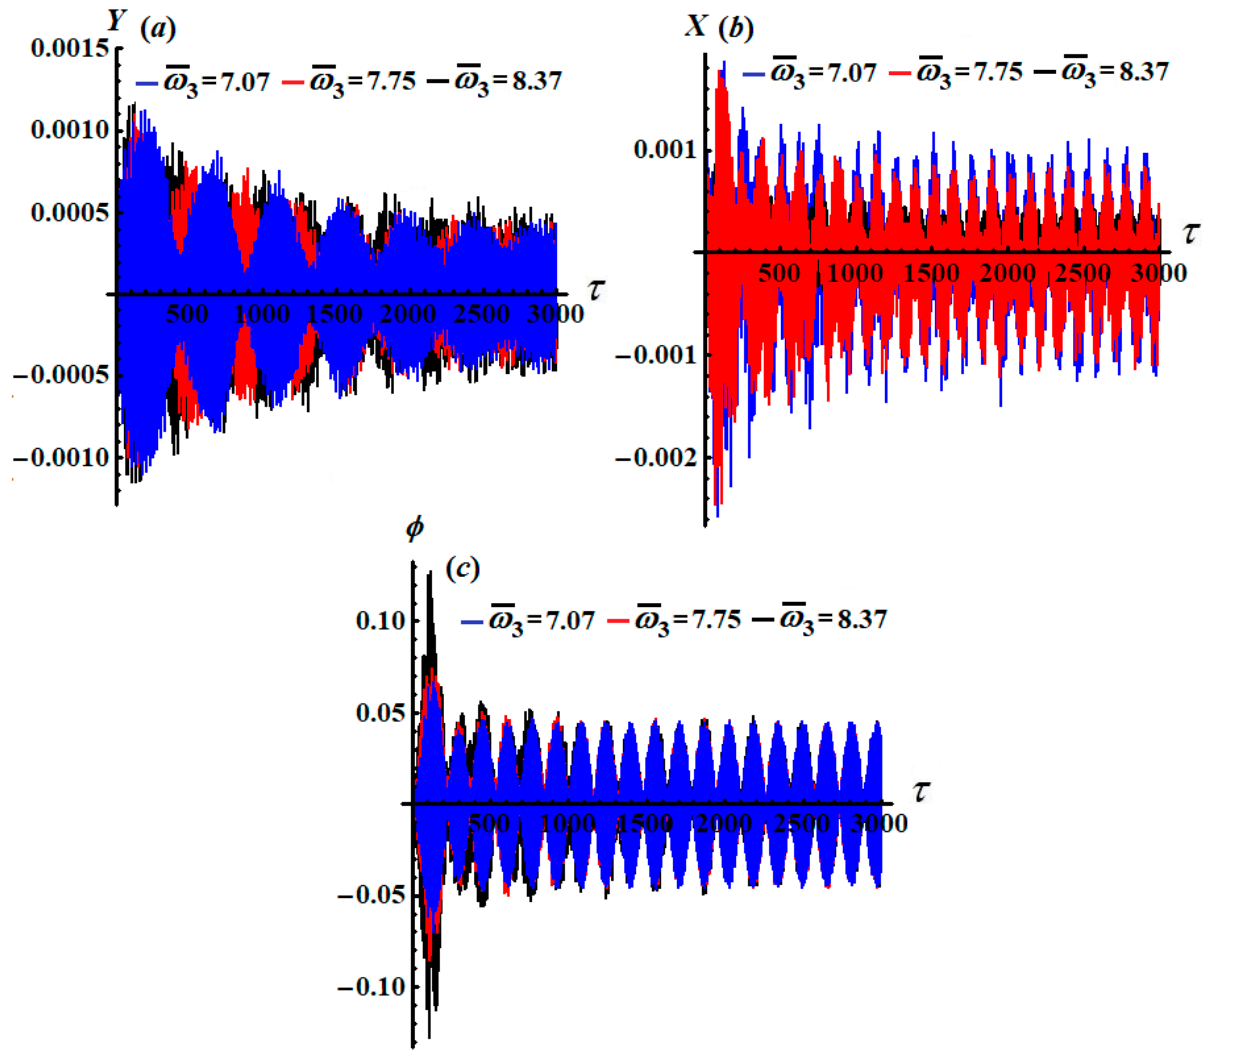
φ ω = τ versus : ( a – c ) when 3 (7.07,7.75,8.37) = ( 7.07,7.75,8.37 ) 3